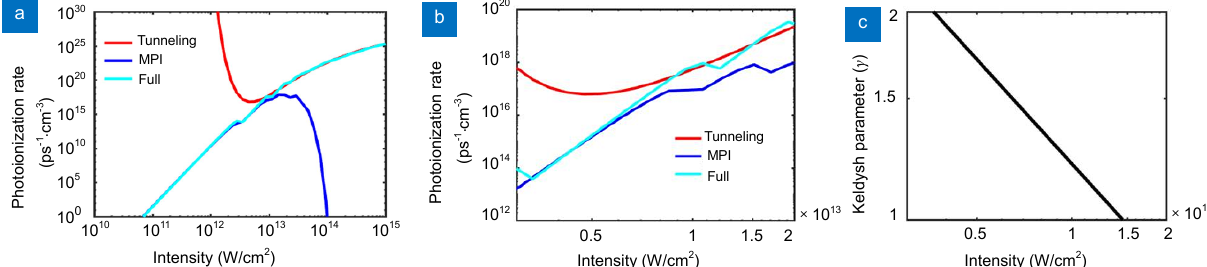
Fig. 3 | ( a ) Total photoionization, MPI and tunneling ionization rate as a function of laser intensity in sapphire. ( b ) Enlarge image where MPI and tunneling ionization rate overlap at a Keldysh parameter of about 1.5. ( c ) Keldysh parameter as a function of laser intensity in